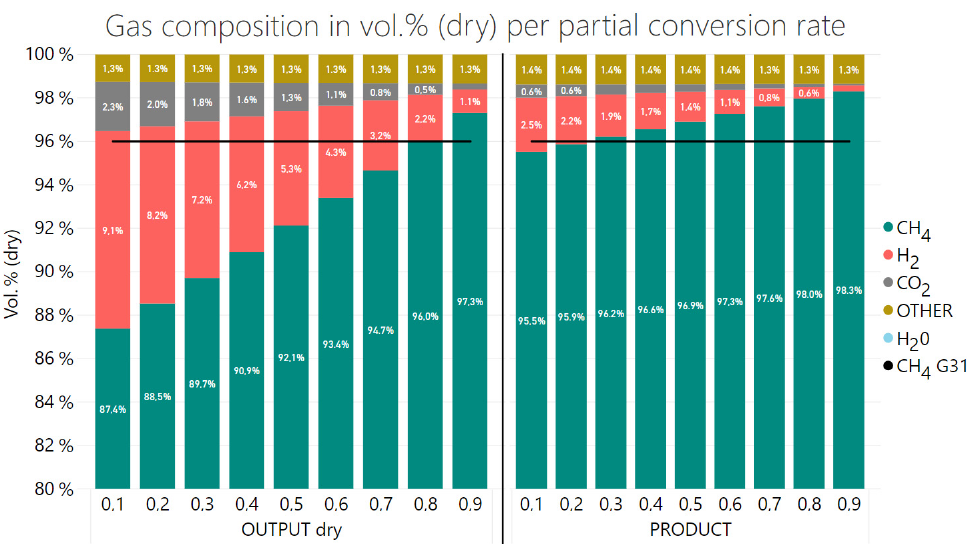
Figure 8. Gas composition of dry gas stream after water separation ( left ), and of product gas stream ( right ); all values in vol.-% (dry) for INPUT Case 1 (10% H 2 and 2.5% CO 2 ).